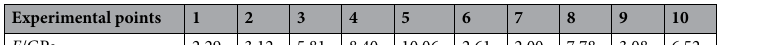
Figure 4. The models of the hind wings. ( a ) In Model I, the veins are set to have varying reduced moduli, and there is no pst structure in the wing. ( b ) In Model II, the veins are set to have a uniform reduced modulus, and there is no pst structure. ( c ) In Model III, the veins are set to have a uniform reduced modulus, and there is a pst structure in the wing. Experimental